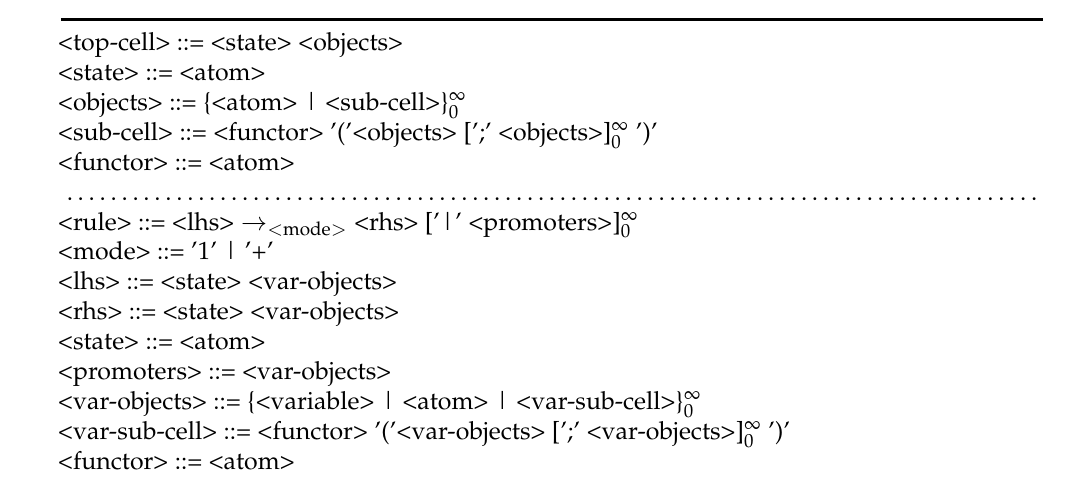
Listing 1. Simplified syntax for single-cell cP systems. Lhs = left-hand-side, rhs = right-hand-side, var-X = X may contain variables. Braces ({,}) and brackets ([,]) are meta-syntactic constructs